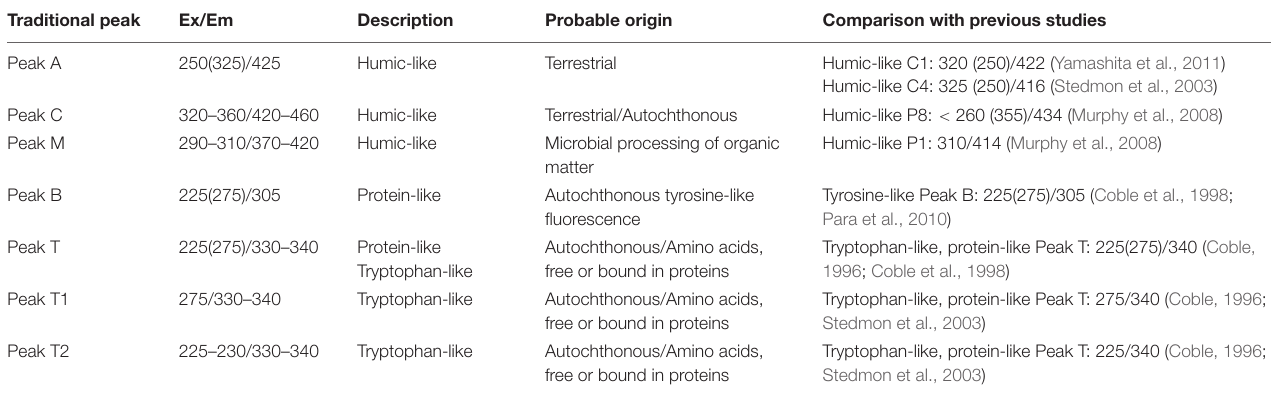
TABLE 1 | Central regions of EEM fluorescence attributed to different sources of organic matter compared with previous studies. Traditional